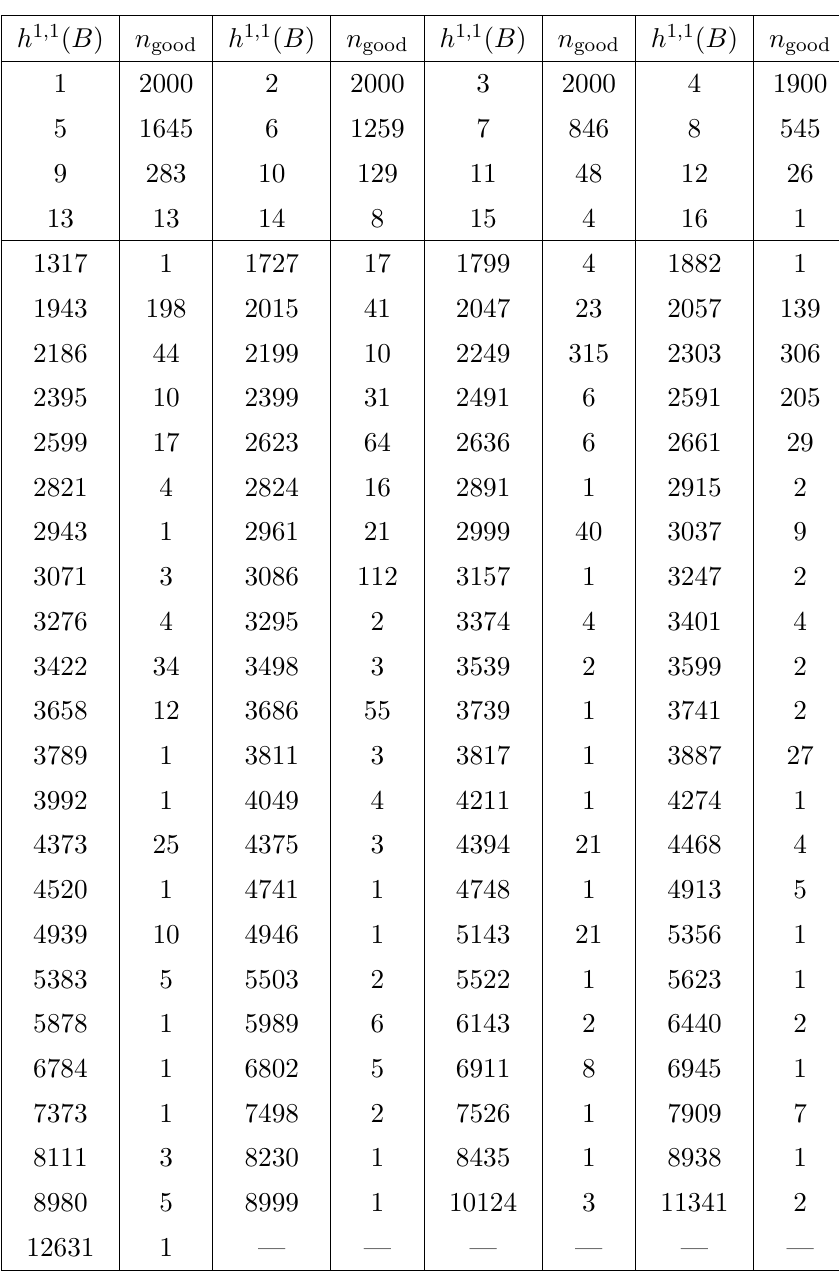
Table 2 . The number of good bases encountered for each h 1 ; 1 ( B ) among the 2,000 runs, without counting the weight factor. Bases at small h 1 ; 1 ( B ) < 20 are not end points, all bases with large h 1 ; 1 ( B ) > 1000 are end points of the algorithm.